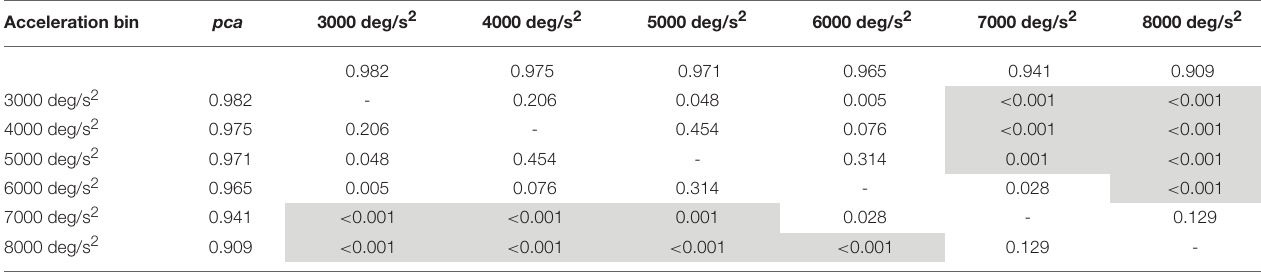
TABLE 3A | Whole athlete group : p -values of the multiple comparisons of pca between head acceleration bin—horizontal canals. Acceleration bin